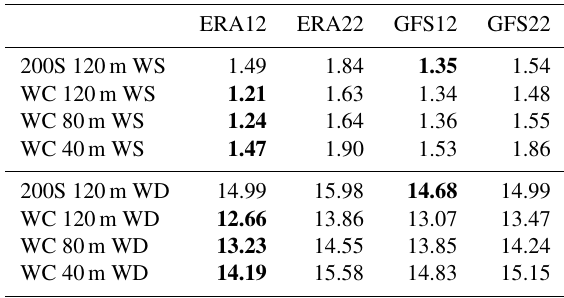
The smallest errors across different WRF settings are highlighted in